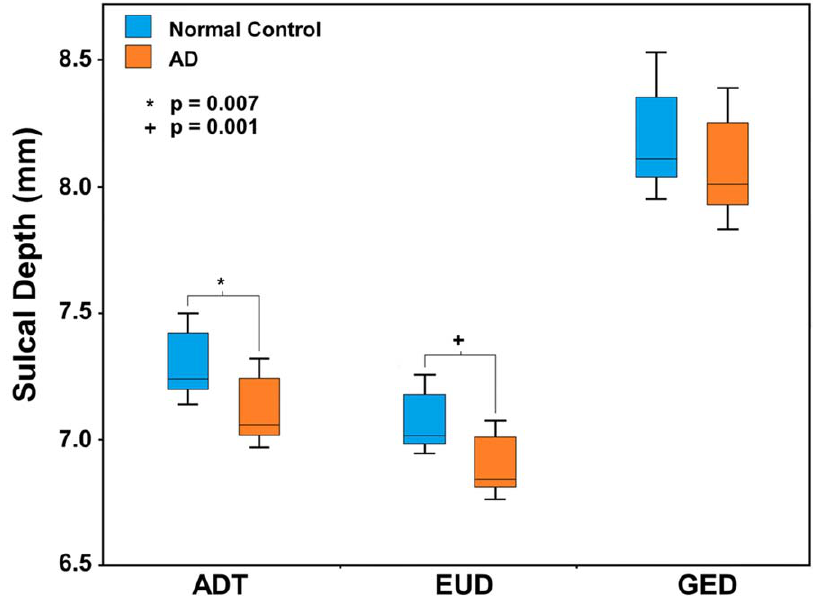
Figure 7. The group difference of mean sulcal depth. Box plot displaying the data distributions and differences in average mean sulcal depth between groups of normal controls and patients with mild AD measured using ADT, EUD and GED.